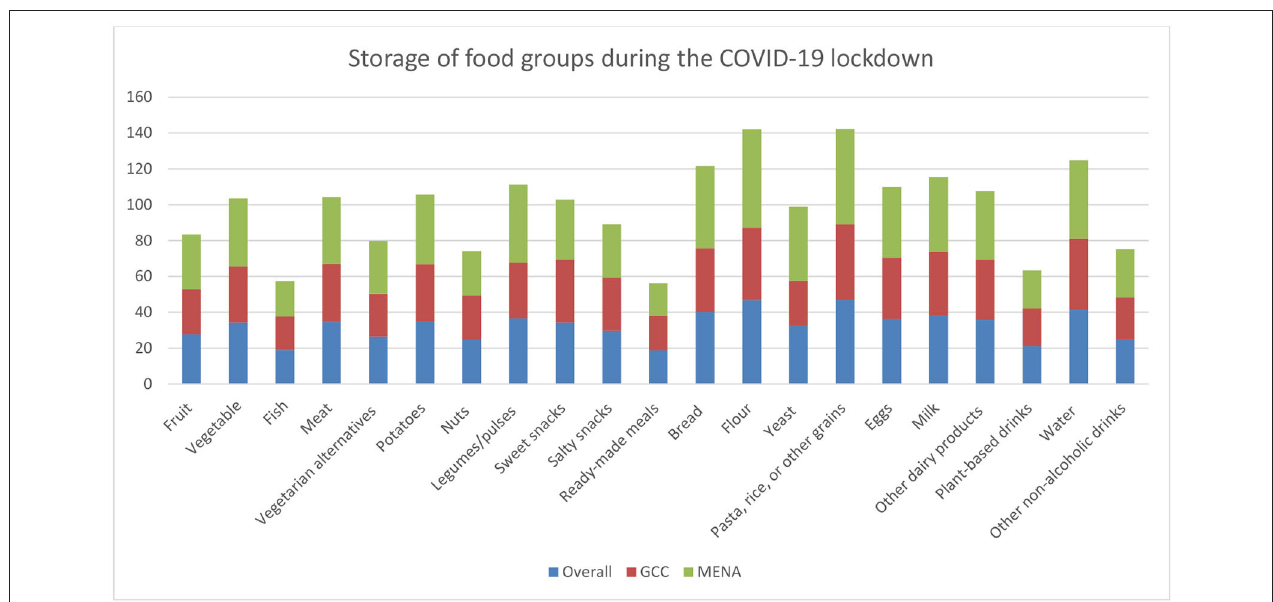
FIGURE 2 | Food stock patterns during the pandemic, overall and by